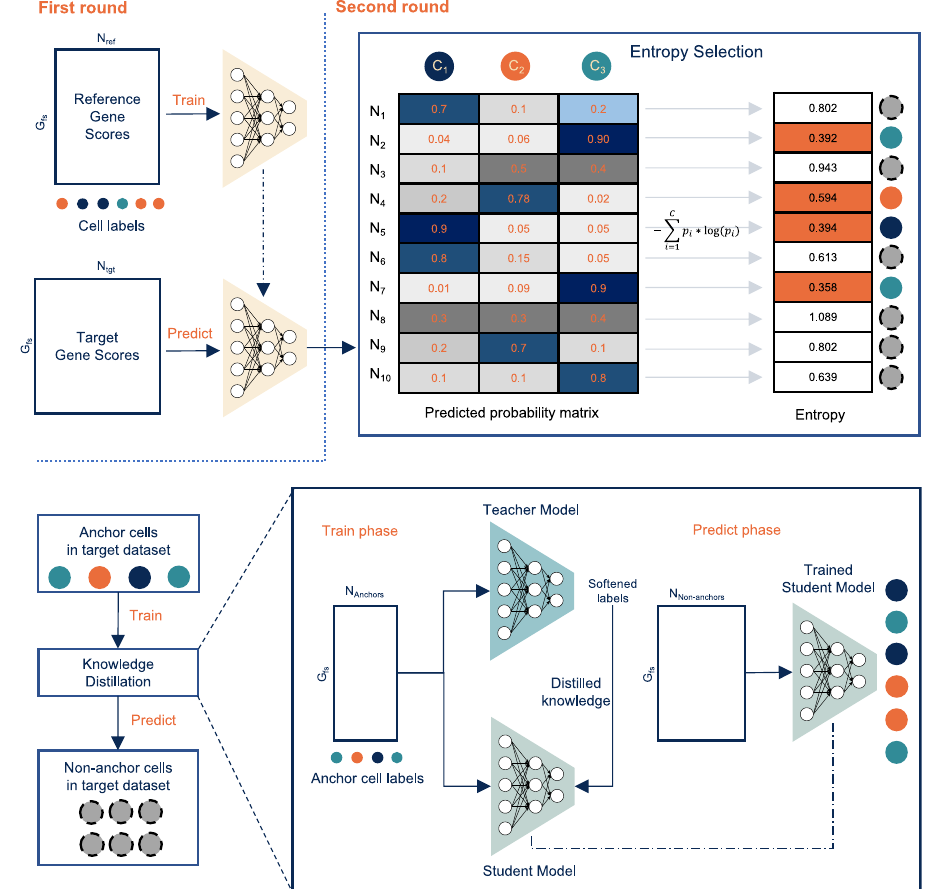
Fig. 1| OverviewofCellcanoframework. Cellcano adopts atwo-round prediction strategy.Inthe fi rstround,CellcanotrainsaMulti-layerPreceptron(MLP)modelon reference gene scores with known cell labels. Then, Cellcano uses the trained MLP topredictcelltypesontargetgenescores.Whenthetargetsizeissuf fi cientlylarge, Cellcano starts the second round by selecting anchors. With the predicted